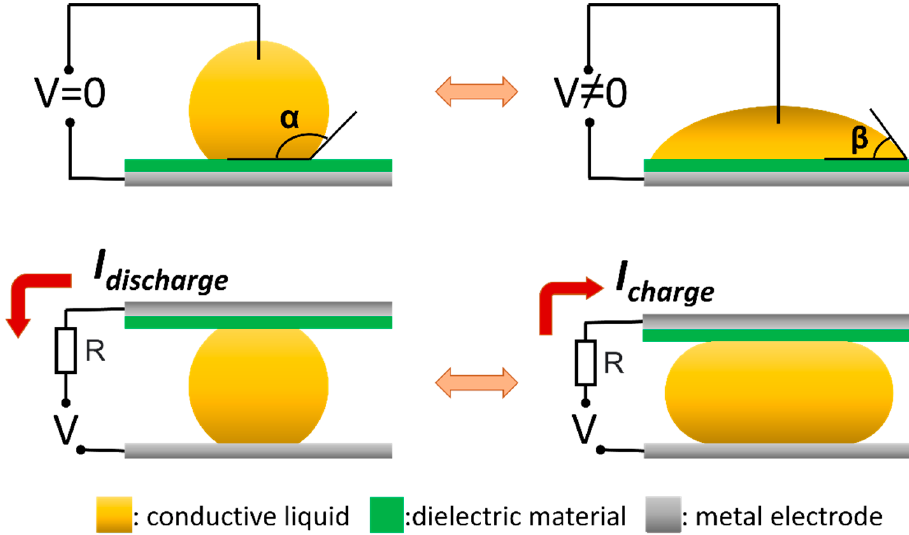
Figure 11. EWOD and REWOD processes